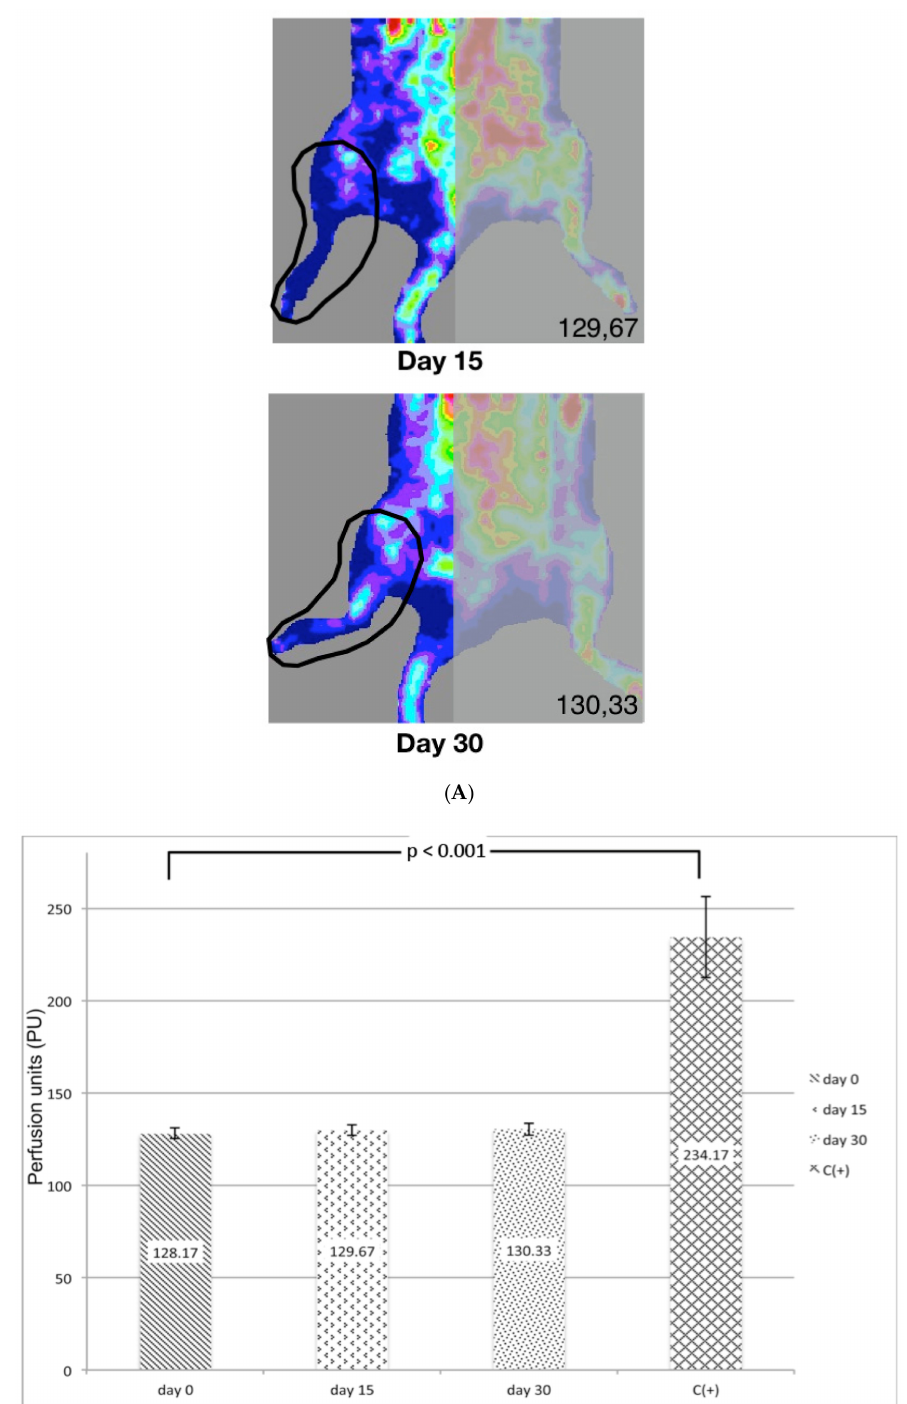
Figure 3. Animals in group A underwent the surgical procedure on day 0. Laser Doppler analysis quantified the degree of ischemia on day 0, day 15 and day 30. ( A ) Thermographic map and region of interest (ROI) comprising the tissue area analyzed on day 0, day 15 and day 30. The picture presents the same animal throughout the experiment. ( B ) Mean perfusion units for group A on day 0 / 15 / 30 ± SD. Day 0 indicates values comparable to day 30. (128.17 PU ± 3.13 vs. 130.33 PU ± 3.27 recorded on day 30, p = n.s.). C( + ) = positive